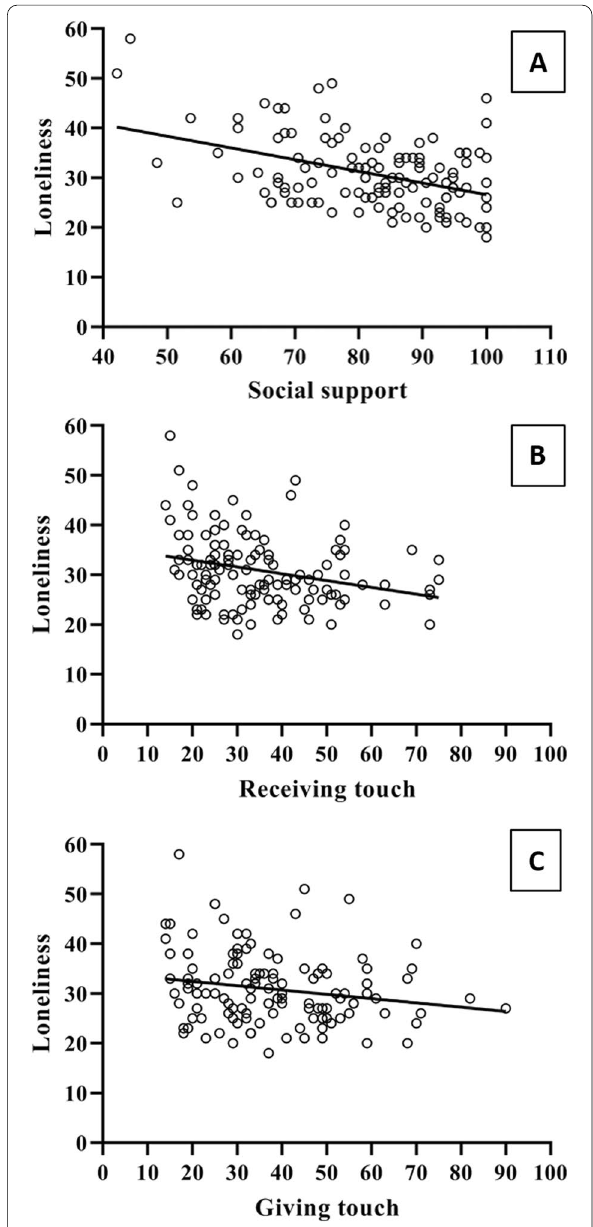
Fig. 1 Graphic representation of regression analyses of loneliness and psychosocial assessments. A Regression analyses predicting loneliness as a function of social support ( Β 0.42, p < 0.001). B =− Regression analyses predicting loneliness as a function of receiving touch ( Β 0.27, p 0.002). C Regression analyses predicting =− = loneliness as a function of giving touch ( Β 0.18, p 0.04) = − =